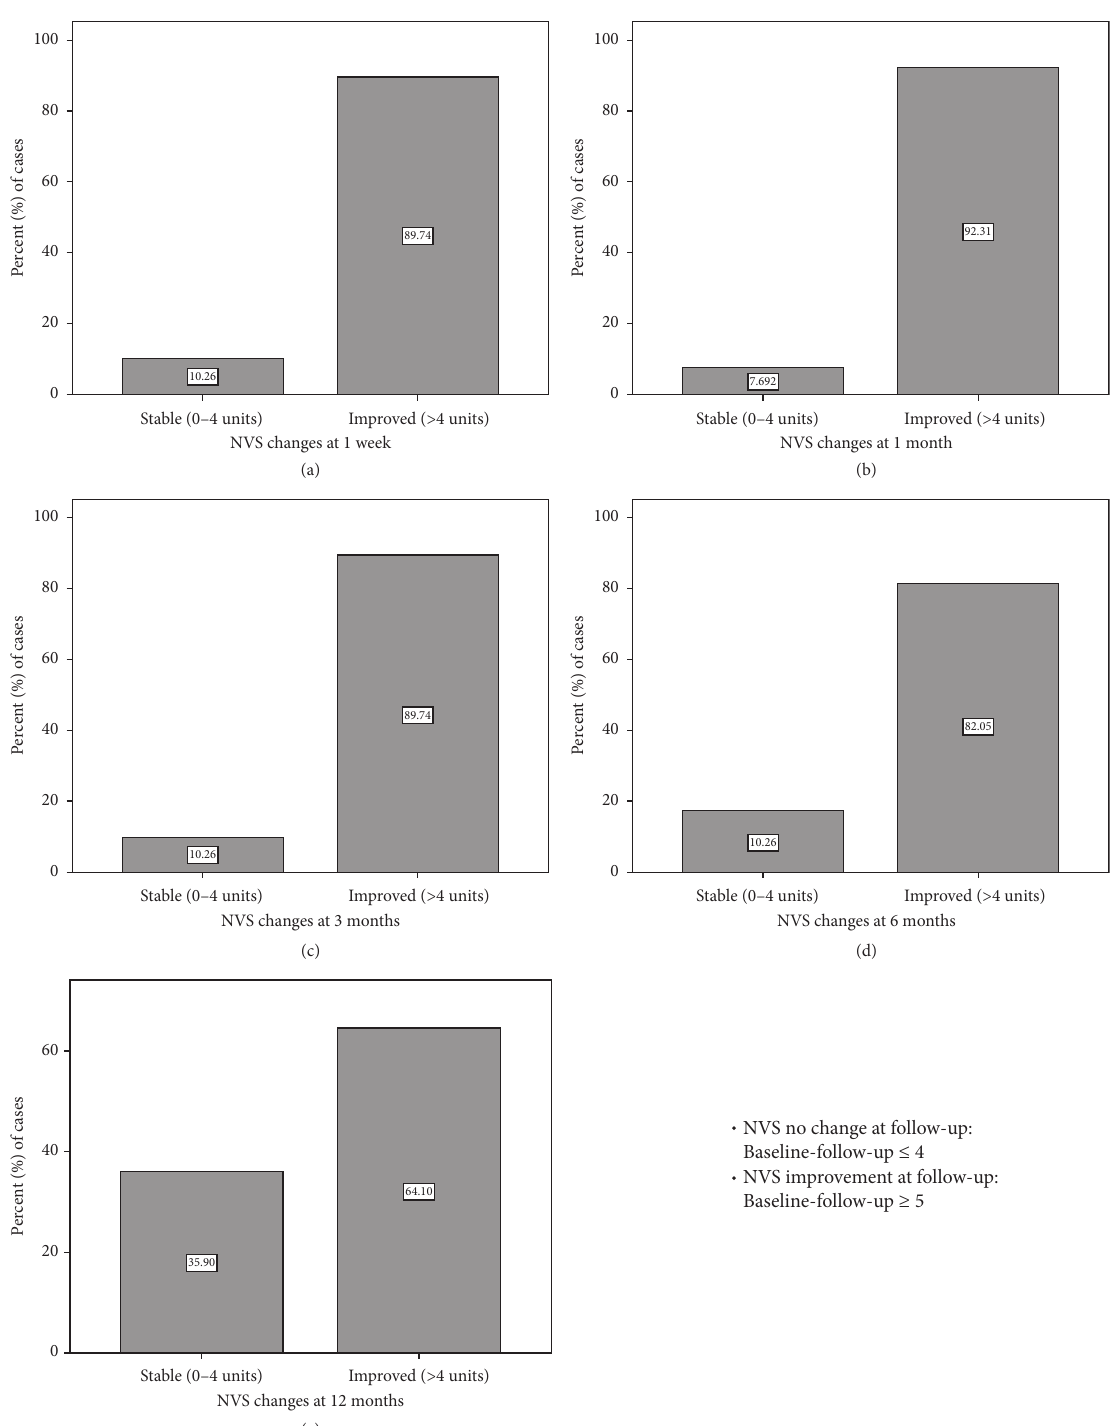
Figure 5: Percentage of cases with no change or improvement of pain based on the comparison between baseline (before RF) and follow-up (post-RF) NVS